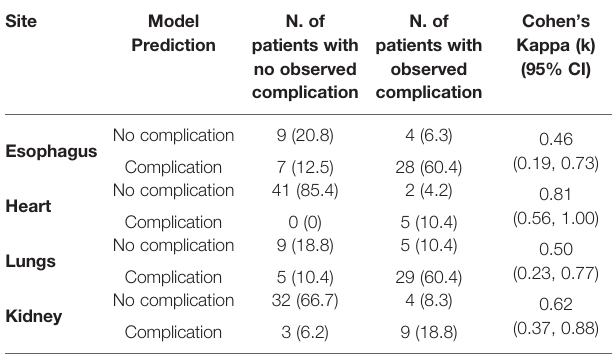
The columns: organ complication predicted by the model. The rows: observed organ complication. Total number of patients: 48/52; four patients were excluded due to the absenceofatleastoneorgancomplication,anecessarycriteriaforthedevelopmentofthe statistical model. k <0.2: poor concordance; k between 0.2 and 0.4: modest concordance; between 0.41 and 0.61: moderate concordance; between 0.61 and 0.80: good concordance; >0.80: excellent